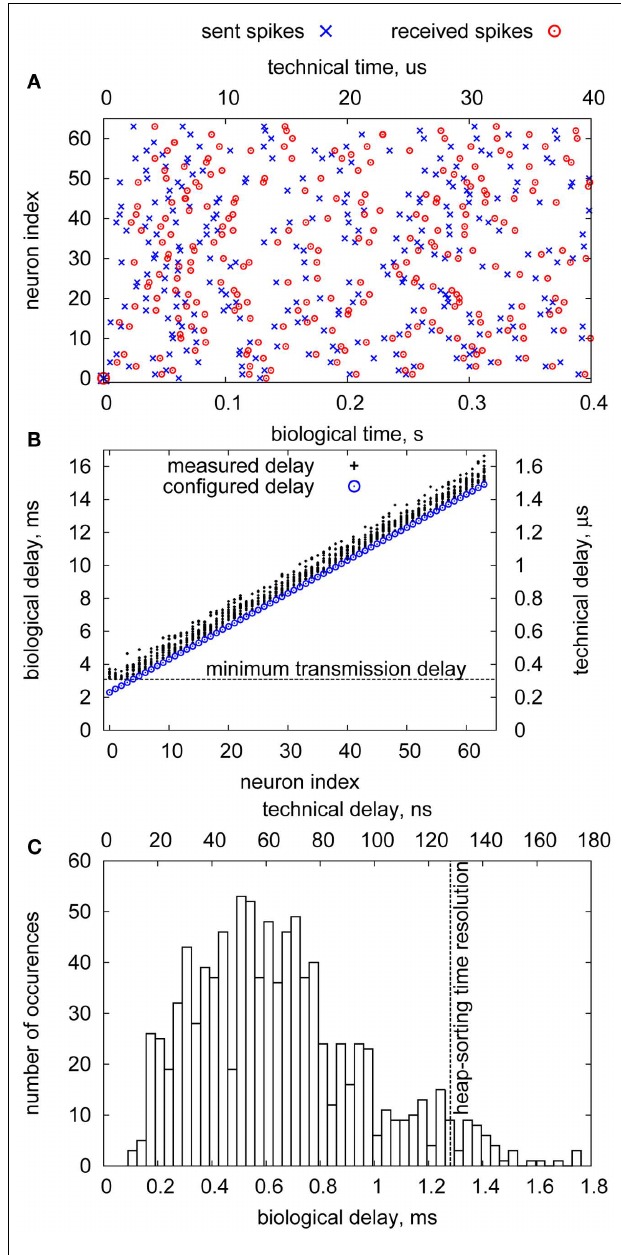
FIGURE 9 | Delay measurement of the FPGA–DNC–HICANN connection. (A) sent/received spikes (B) measured delays (C) delay jitter.